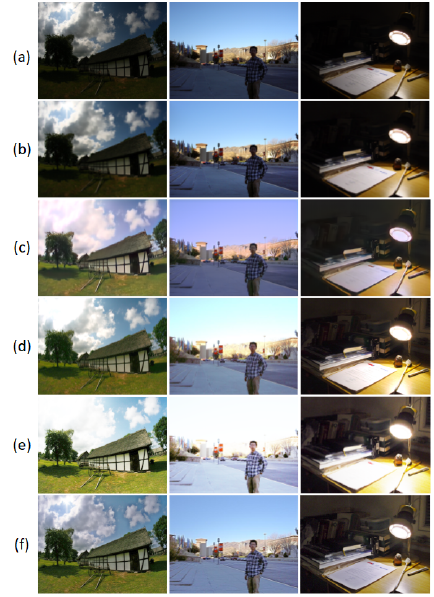
Figure 13. Comparison of visual effects with a different number of iterations.